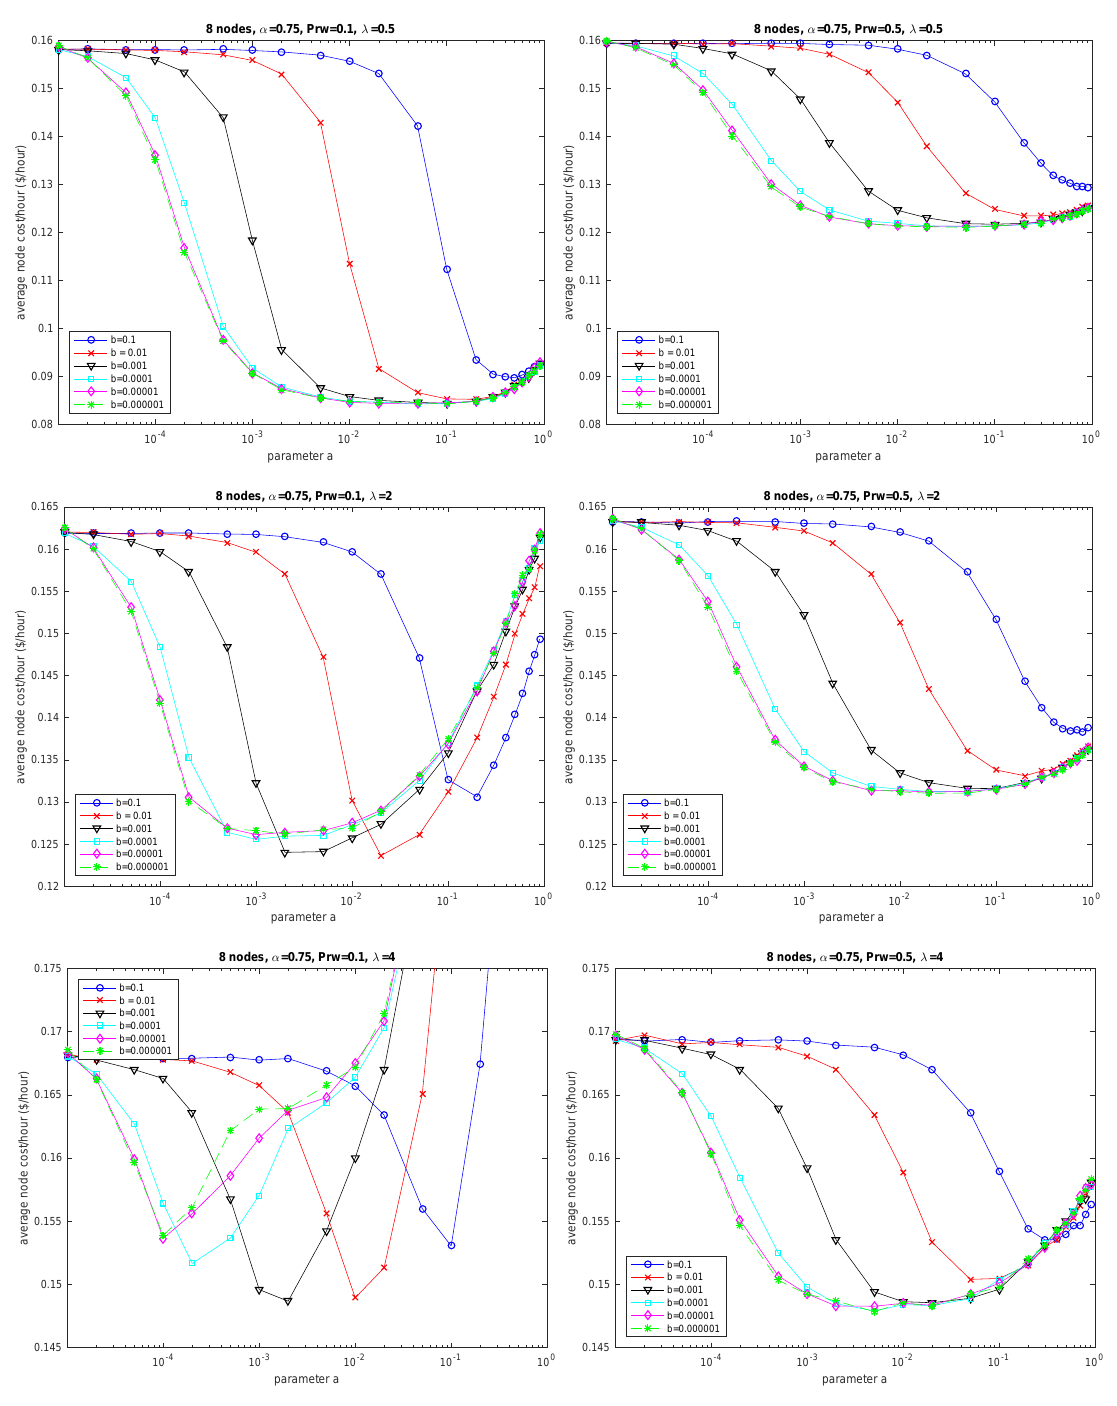
Figure 3. Impact of learning parameters a and b